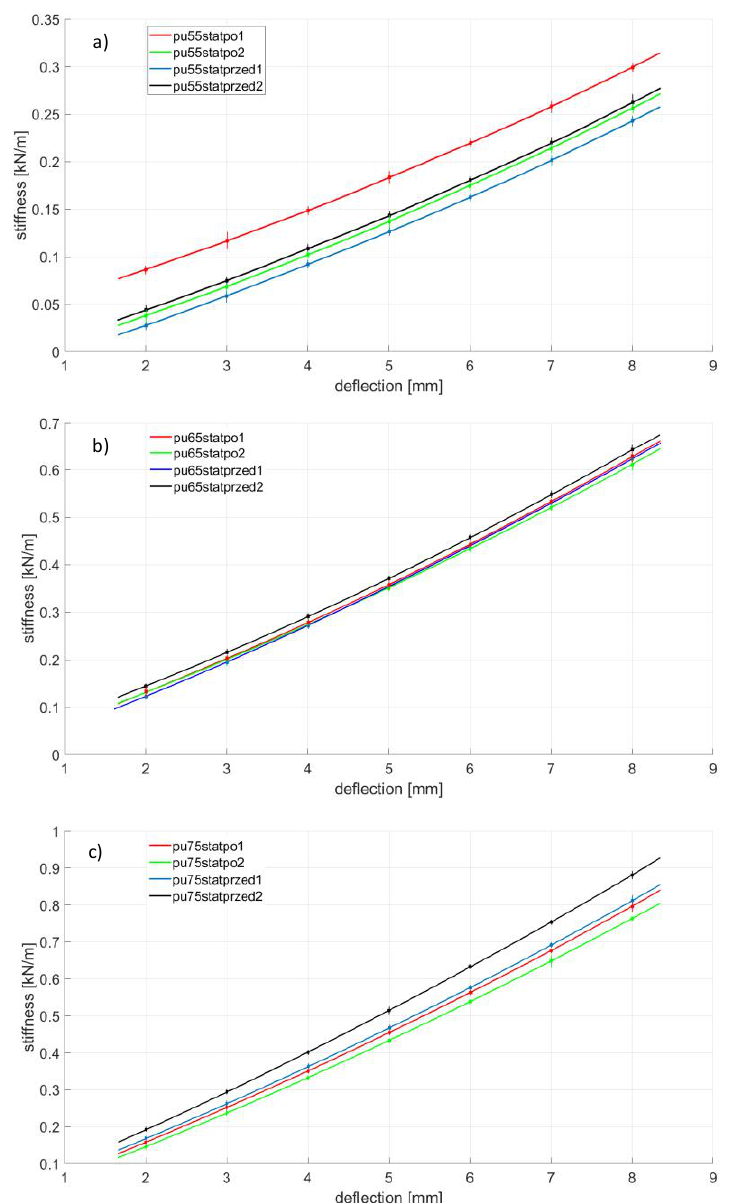
Figure 11. PU changes of stiffness during various tests conducted on the tensile machine, ( a ) — PU 55 Sh A, ( b ) — PU 65 Sh A, ( c ) — PU 75 Sh A.